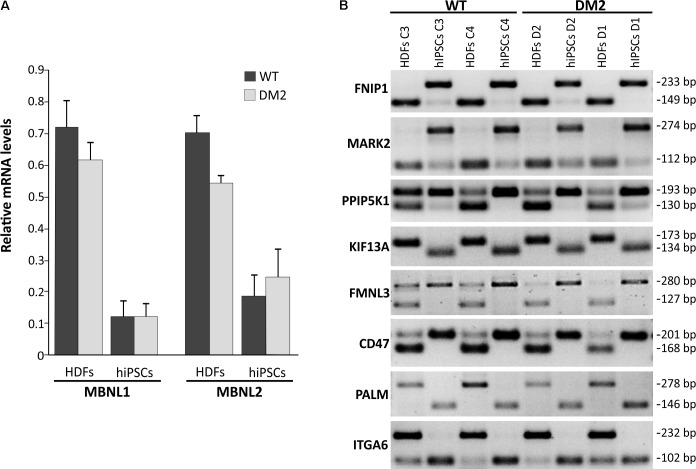
RT-qPCR analysis of MBNL1 and MBNL2 gene and alternative splicing assay. (A) RT-qPCR assay for MBNL1 and MBNL2 genes expression in the HDFs to hiPSCs transition of WT and DM2 lines. Gene expression levels reported are an average of the WT and DM2 cell lines normalized to β-actin used as reference gene. (B) Eight-switch-like splicing changes of genes regulated by MBNL1 protein have been assessed by conventional RT-PCR analysis during the HDFs to hiPSCs transitions in WT and DM2 lines. The upper and lower bands on each gel represent the long (exon-included) and short (exon-omitted) isoforms, respectively.